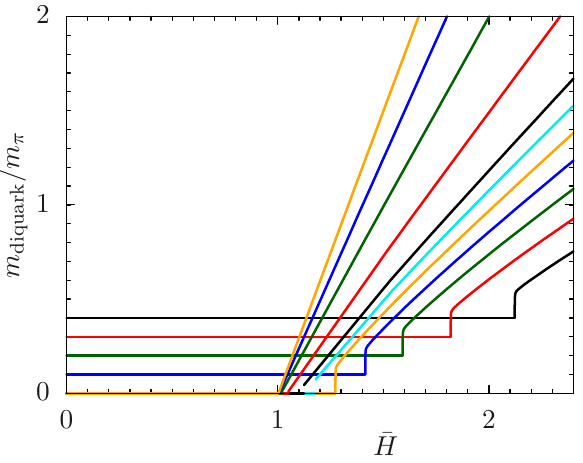
Figure 6 . Rescaled mass of the lighter of the two diquarks as a function of the magnetic (cid:12)eld (cid:22) H for several (cid:12)xed values of the rescaled chemical potential x . Going from right to the left, the individual curves correspond to x = 0 : 6 (black), 0 : 7 (red), 0 : 8 (green), 0 : 9 (blue), 1 : 0 (orange), 1 : 1 (cyan), 1 : 2 (black), 1 : 5 (red), 2 : 0 (green), 2 : 5 (blue), and 3 : 0 (orange). The (cid:12)rst-order nature of the transition between the BEC and CSL phases is clearly visible for the x = 1 : 1 and x = 1 : 2 curves. For higher x , the discontinuity is so small that it is not visible in the